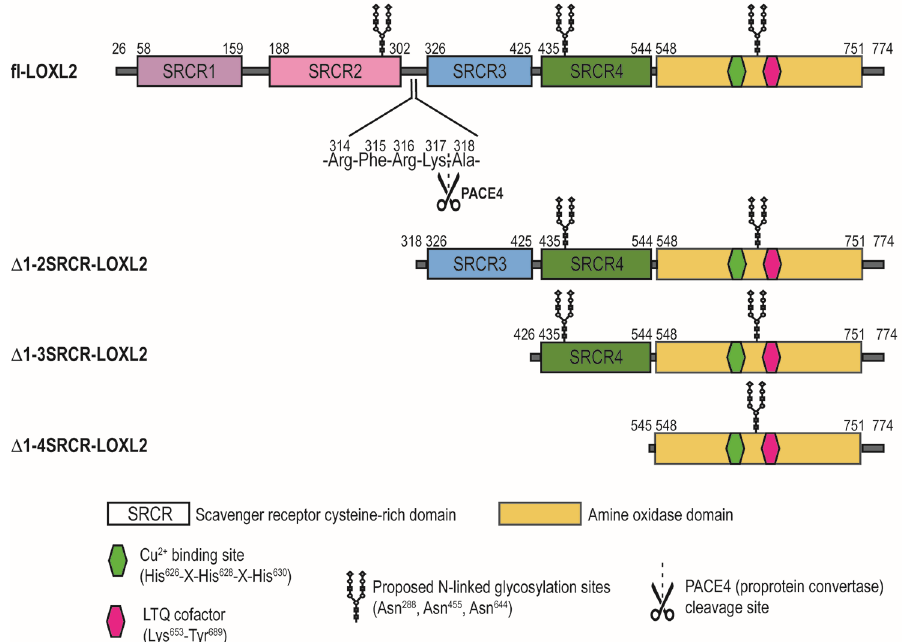
Figure 1. A schematic diagram of rLOXL2s in this study. fl-LOXL2: full-length LOXL2; Δ 1-2SRCR- LOXL2: LOXL2 which lacks the first two SRCR domains; Δ 1-3SRCR-LOXL2: LOXL2 which lacks the first three SRCR domains; Δ 1-4SRCR-LOXL2: LOXL2 which lacks all four SRCR domains. LOXL2 secretes as ~100-kDa full-length protein (fl-LOXL2) and that undergoes prote- olytic cleavage of the first two SRCR domains by PACE4, a proprotein convertase, at Arg 314 -Phe 315 -Arg 316 -Lys 317 ↓ Ala 318 (underlined: the recognition sequence of PACE4) to yield ~60-kDa protein ( Δ 1-2SRCR-LOXL2) [4]. In vitro, this processing does not affect the amine oxidase activity of LOXL2 in the oxidation of cadaverine and tropoelastin,